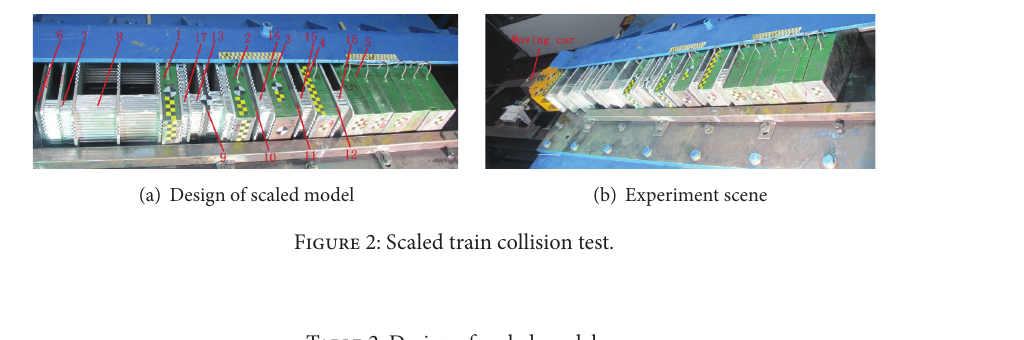
Table 2: Design of scaled